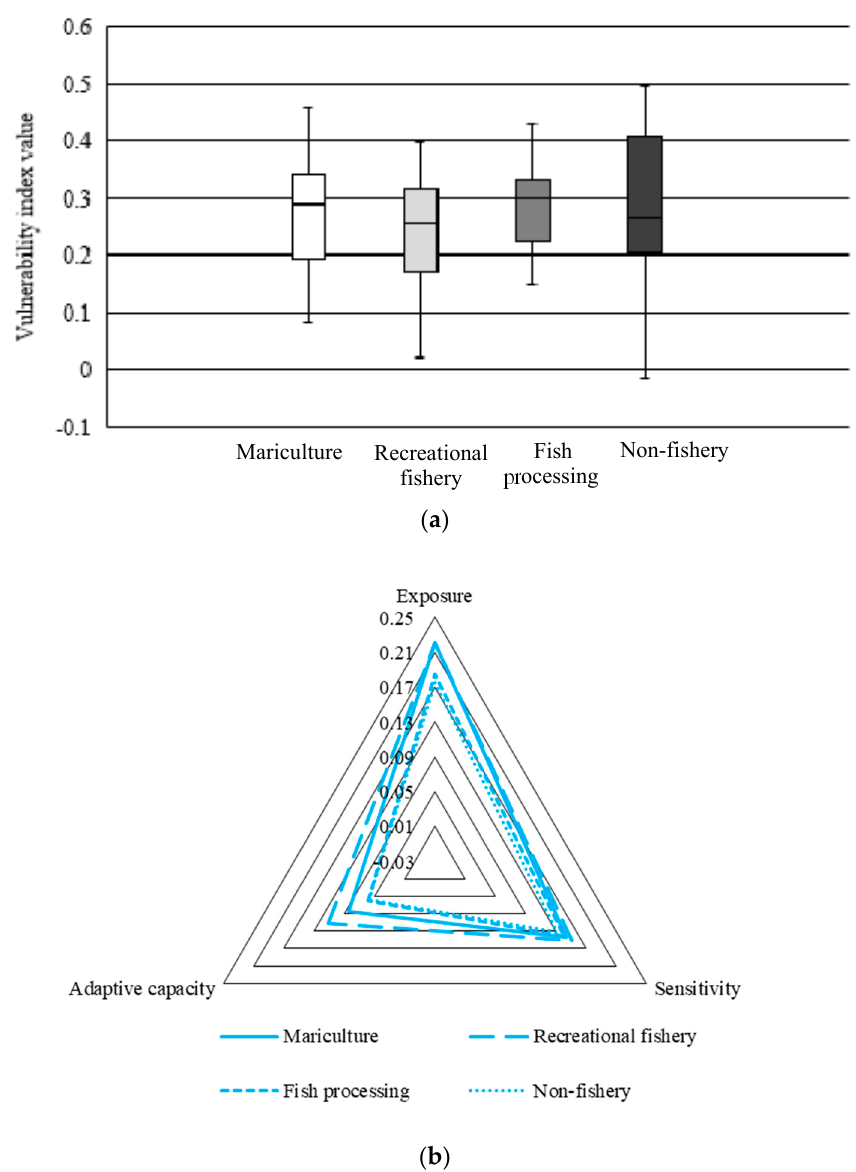
Figure 4. The LVI for different types of converted fishermen: (a) Box plot of the LVI values; (b) Radar chart of the exposure index, sensitivity index, and adaptive capacity index.